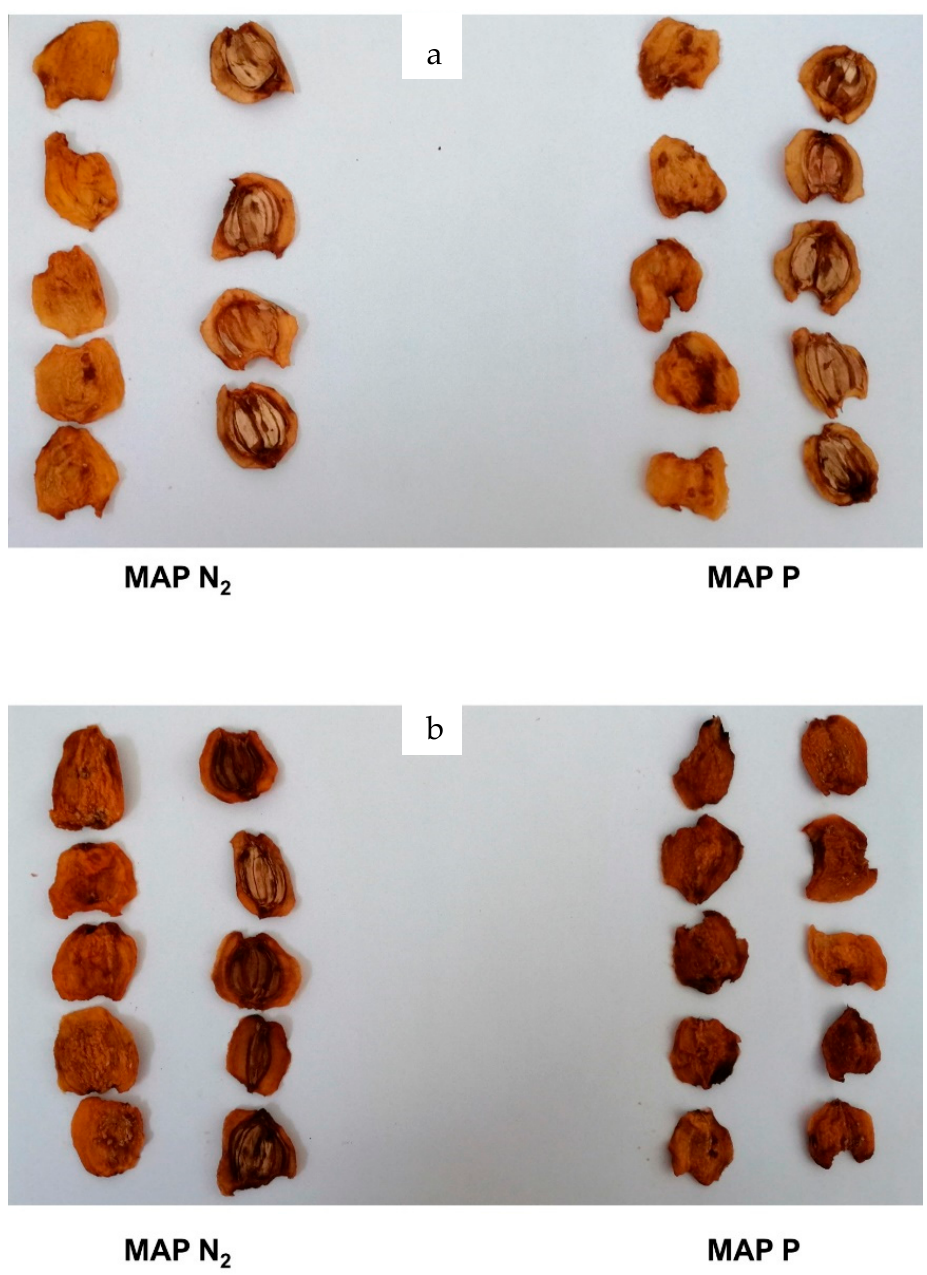
Figure 1. A representative sample of the cultivars Claudia ( a ) and Peluche ( b ) after 50 days of storage with MAP N 2 and MAP P treatment.